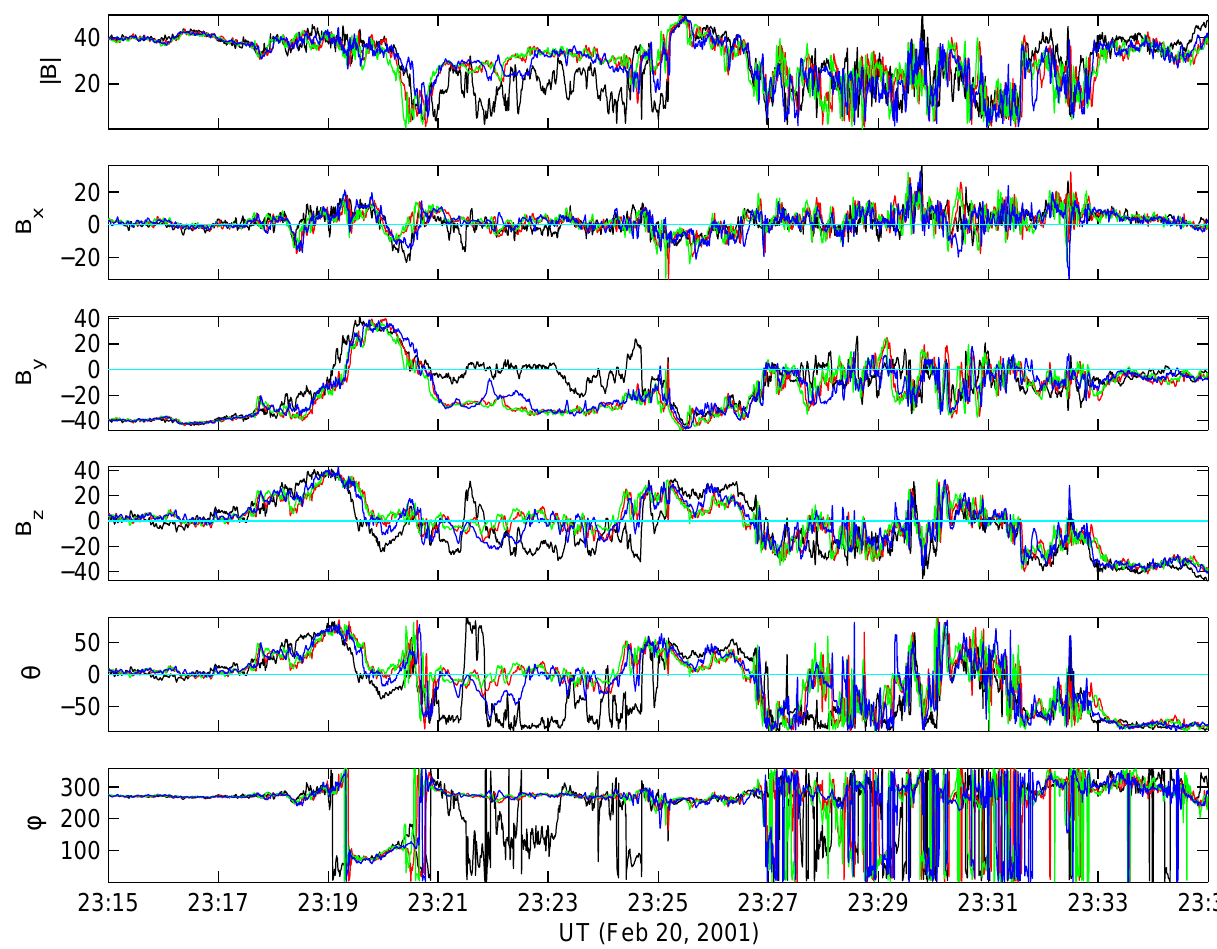
Fig. 12. The magnetic field with a resolution of 4 vectors per second from 23:15–23:35UT on 20 February 2001. The six panels show the magnetic field magnitude, components and orientations (expressed as the angles θ and φ ) in GSE coordinates.